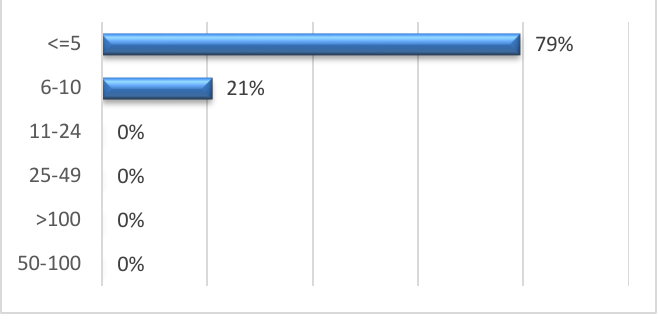
Figure 11: Number of Employees ; Source: